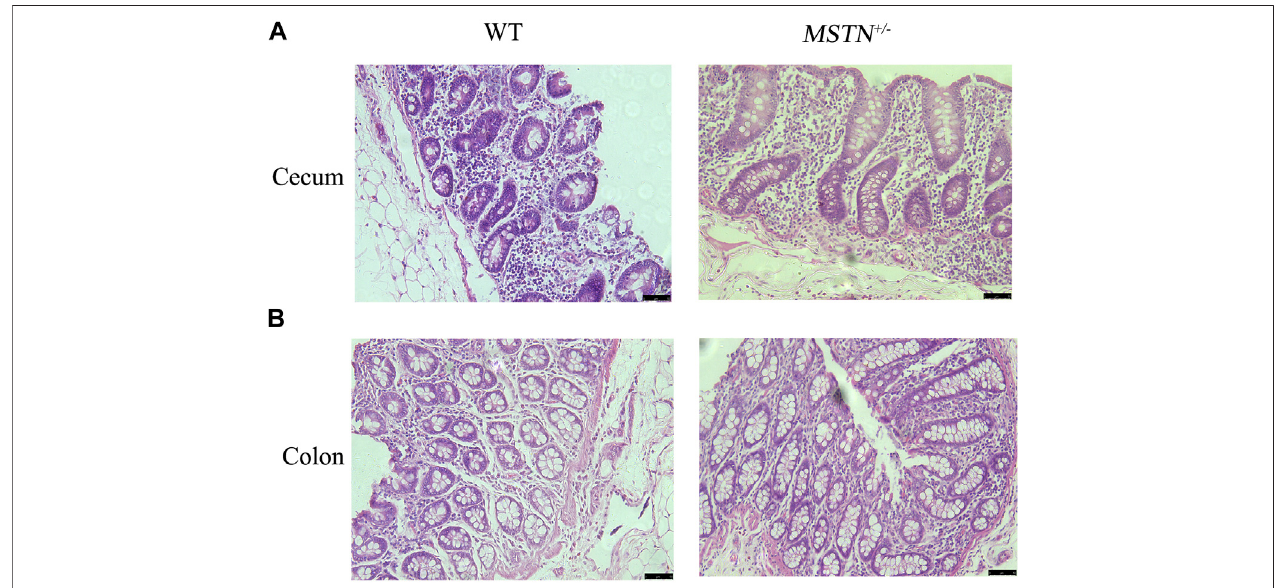
FIGURE3| Histologicalanalysisofcecumandcolonin5-month-old MSTN +/ − andWTpigs. (A,B) Histologyofcecum (A) andcolon (B) fromWT(left)and MSTN +/ −